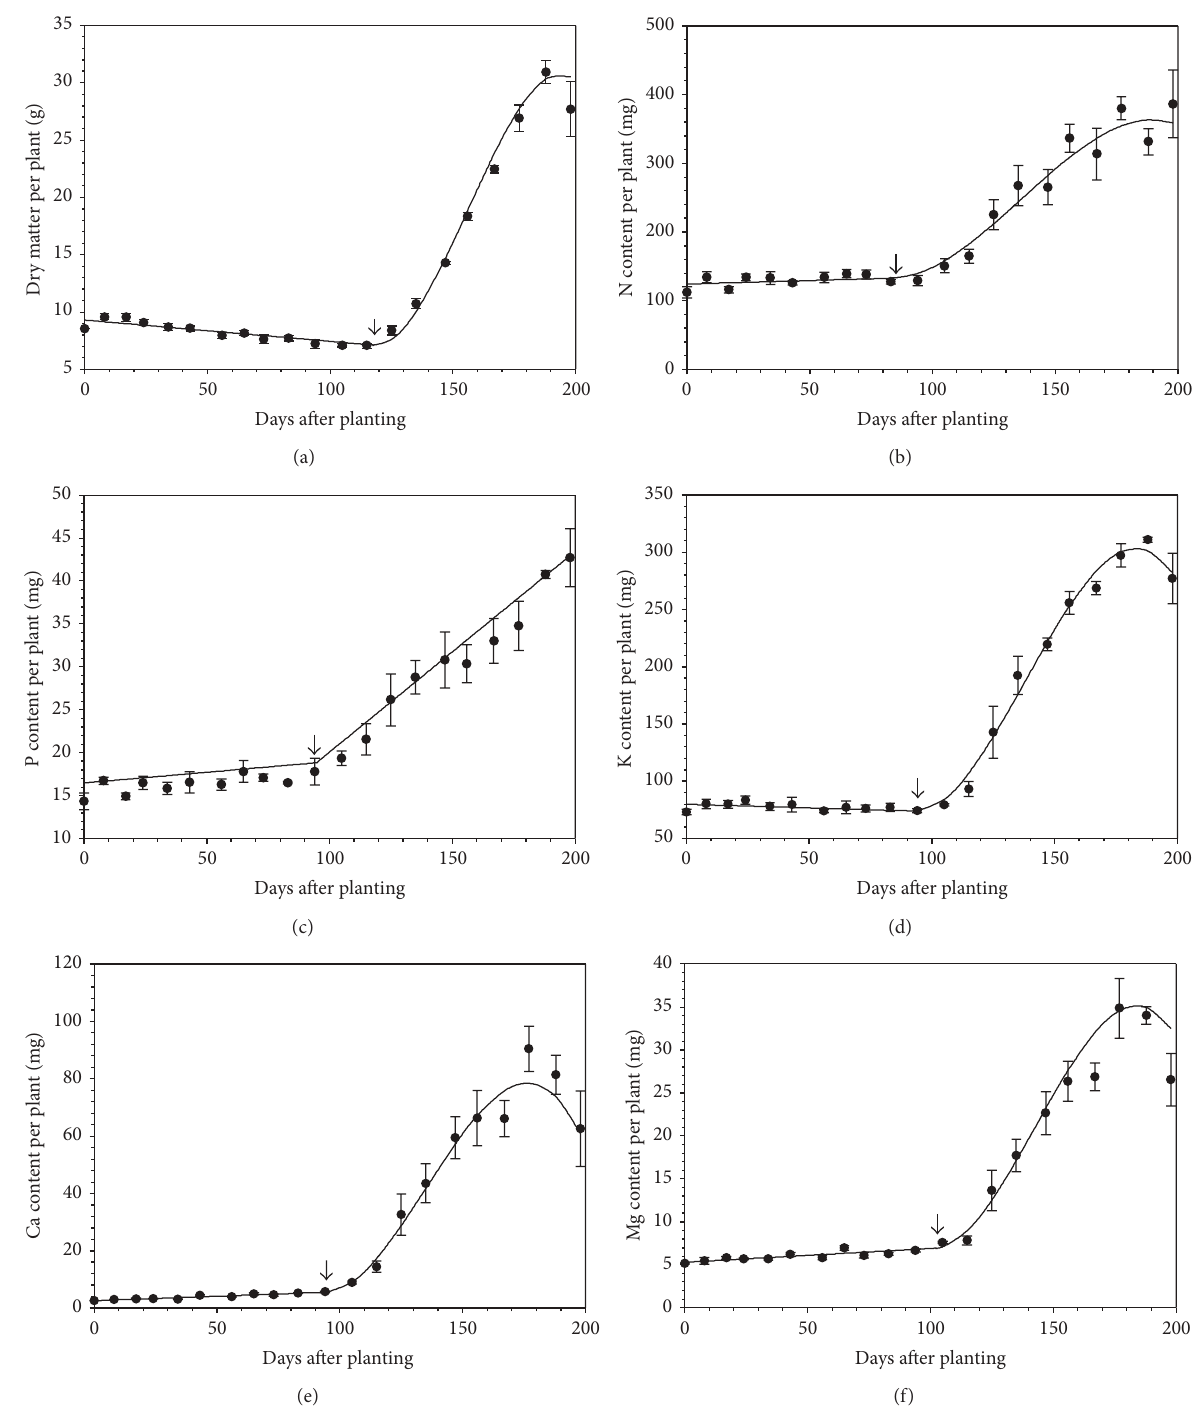
Figure 4: Changes in total dry matter (a) and N (b), P (c), K (d), Ca (e), and Mg (f) content from planting through final harvest in T. gesneriana “Paul Richter” during the growing season. For dry matter, N, K, Ca, and Mg, the arrow in each graph indicates the join points for the linear and cubic components of each curve. For P, the arrow in the graph indicates the join point for the two linear components of the curve. The equations for the above curves are as follows. (a) If 𝑥 ≤ 117.7, then 𝑦 = 9.287 − 0.0186 𝑥 and if 𝑥 >